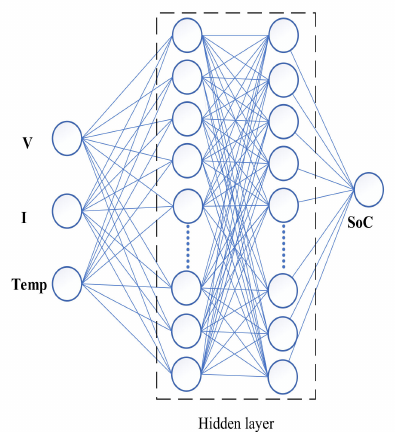
Figure 24. ANN structure for the proposed model with 3 inputs, dual hidden layer and single